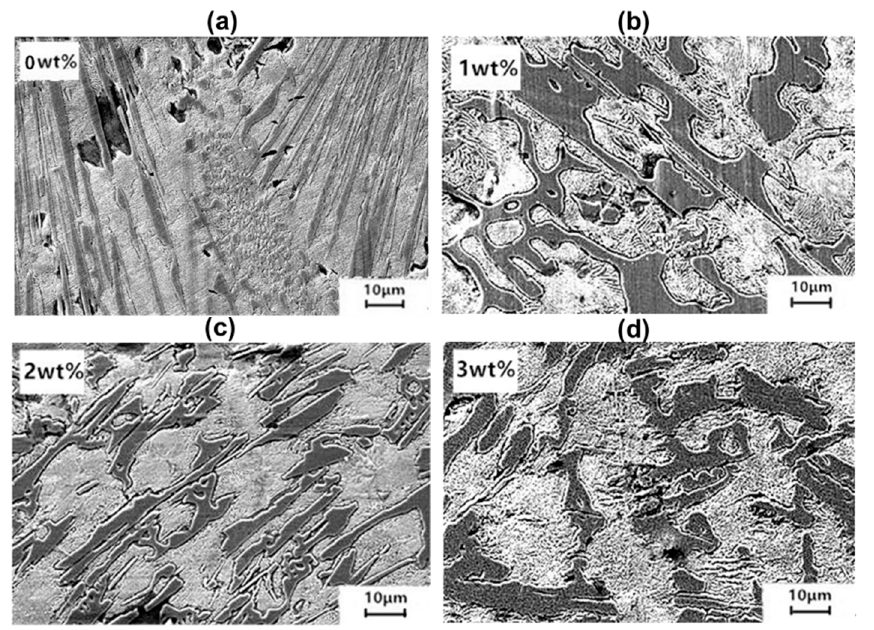
Figure 2. Microstructures of the white cast iron specimens with ( a ) 0 wt.% Ti 3 AlC 2 additive; ( b ) 1 wt.% Ti 3 AlC 2 additive; ( c ) 2 wt.% Ti 3 AlC 2 additive; ( d ) 3 wt.% Ti 3 AlC 2 additive.